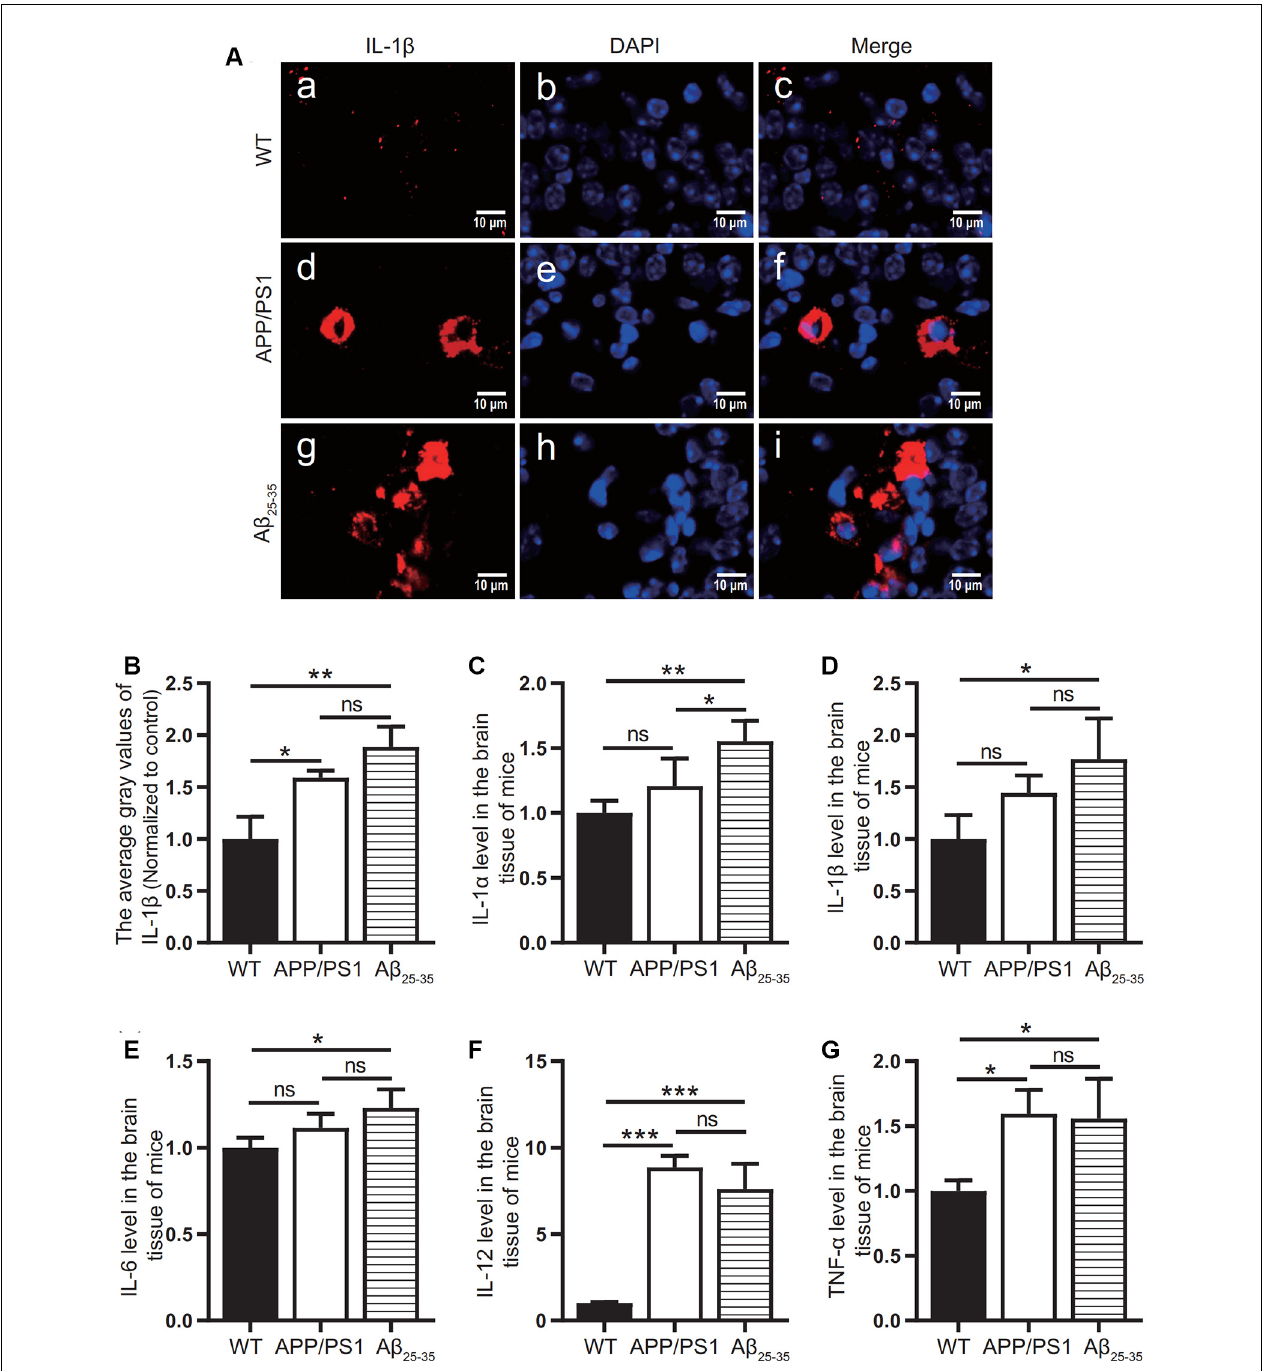
FIGURE 4 | Expression of inflammatory factors in AD animal models. (A) Immunofluorescence was used to analyze the inflammatory protein IL-1 β in the brain tissues of the WT group, APP/PS1 group, and A β 25–35 group. (B) The difference in fluorescence intensity between groups was compared. (C–G) The expression levels of the inflammatory factors IL-1 α , IL-1 β , IL-6, IL-12, and TNF- α in the brain tissues of the WT group, APP/PS1 group, and A β 25–35 group mice were detected (* p < 0.05, ** p < 0.01, *** p < 0.001; “ns” means there is no significant difference; n = 3).